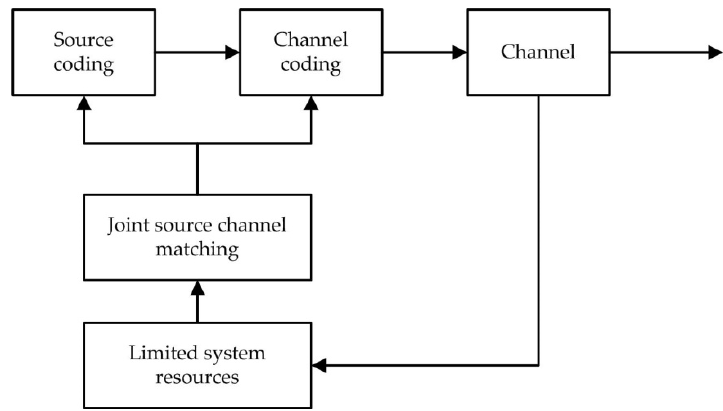
Figure 11. The bit allocation strategy for joint source channel coding.